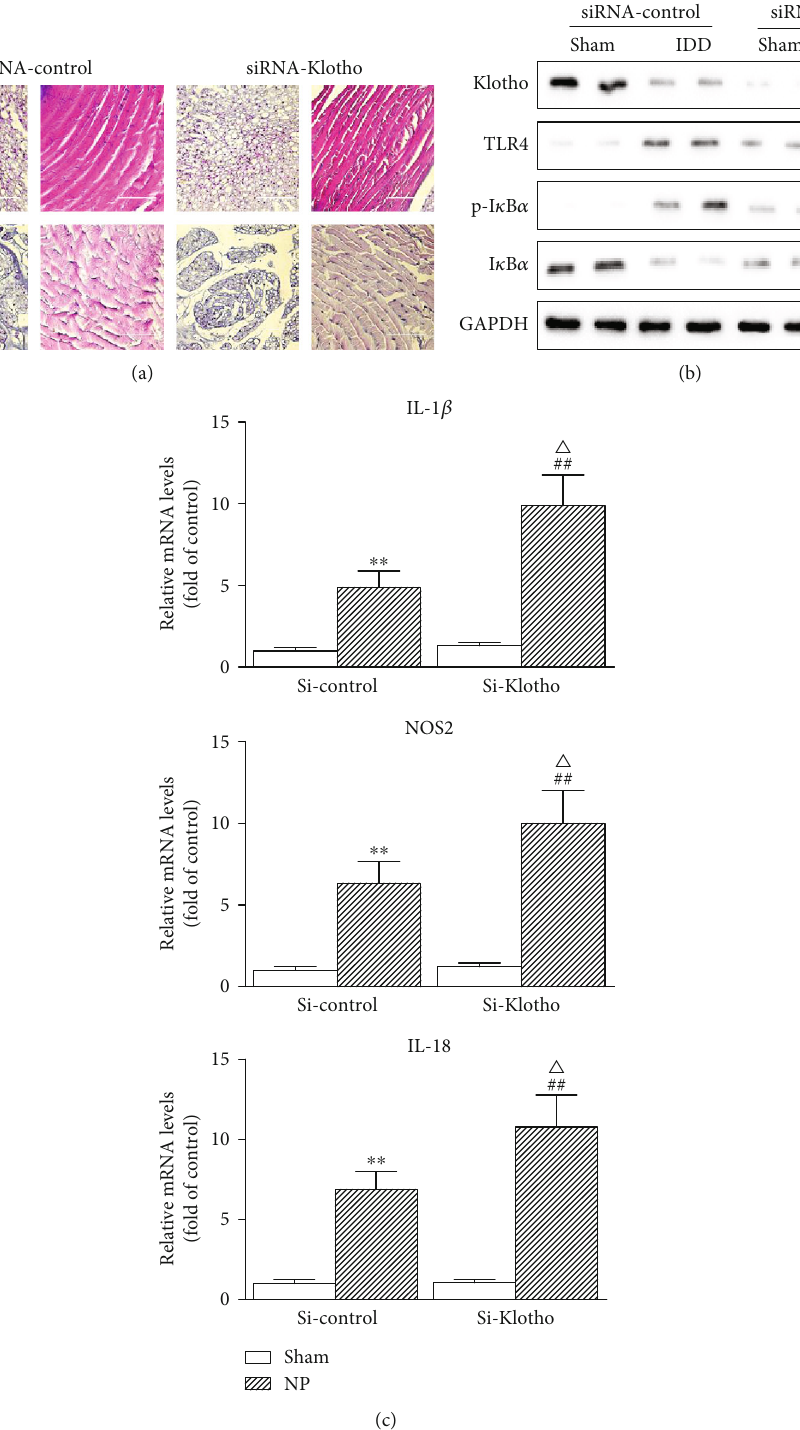
Figure 5: Functional role of Klotho in degenerative intervertebral disc. Rats injected with either siRNA-control or siRNA Klotho were treated with or without needle puncture for 2 weeks. (a) Representative photomicrographs of H&E-stained intervertebral disc sections ( n = 6 in each group). Typical histologic appearance of the AF and NP from normal and degenerated discs induced by percutaneous needle puncture. Scale bar, 20 μ m (original magni fi cation × 40). (b) Expressions of Klotho, TLR4, p-I κ B α , and I κ B α were assayed by Western blotting (two randomly selected samples from each group were shown). (c) mRNA levels of IL-1 β , NOS2, and IL-18 from rats were assayed by qRT-PCR and quanti fi ed as fold changes ( n = 6 in each group). Data were presented as mean ± SD . ∗∗ P < 0 : 01 vs. sham in siR-control group; ## P < 0 : 01 vs. sham in siRNA Klotho group; △ P < 0 : 05 vs. IDD in siRNA-control